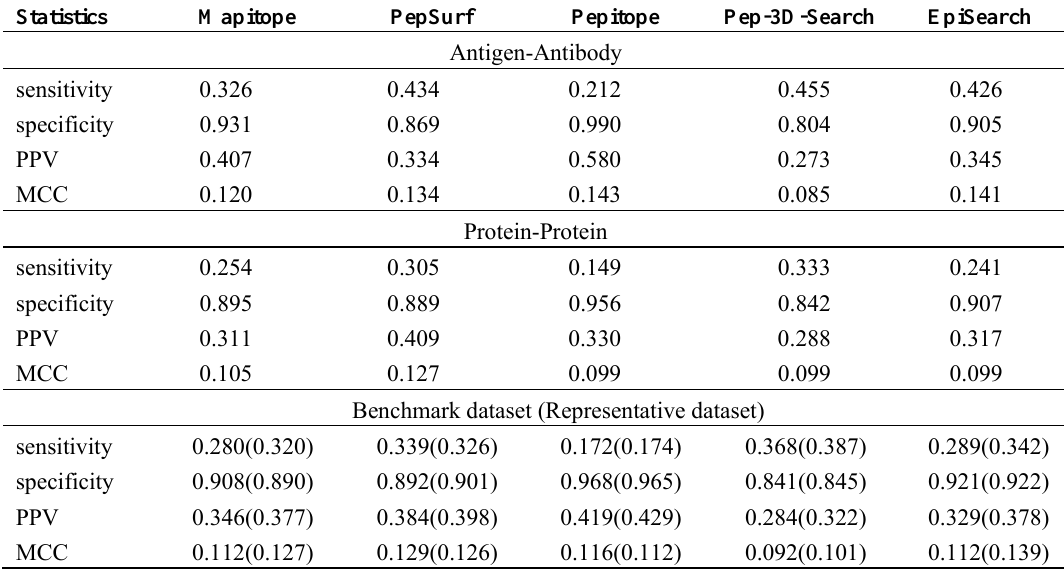
Table 4. Overall performance of each